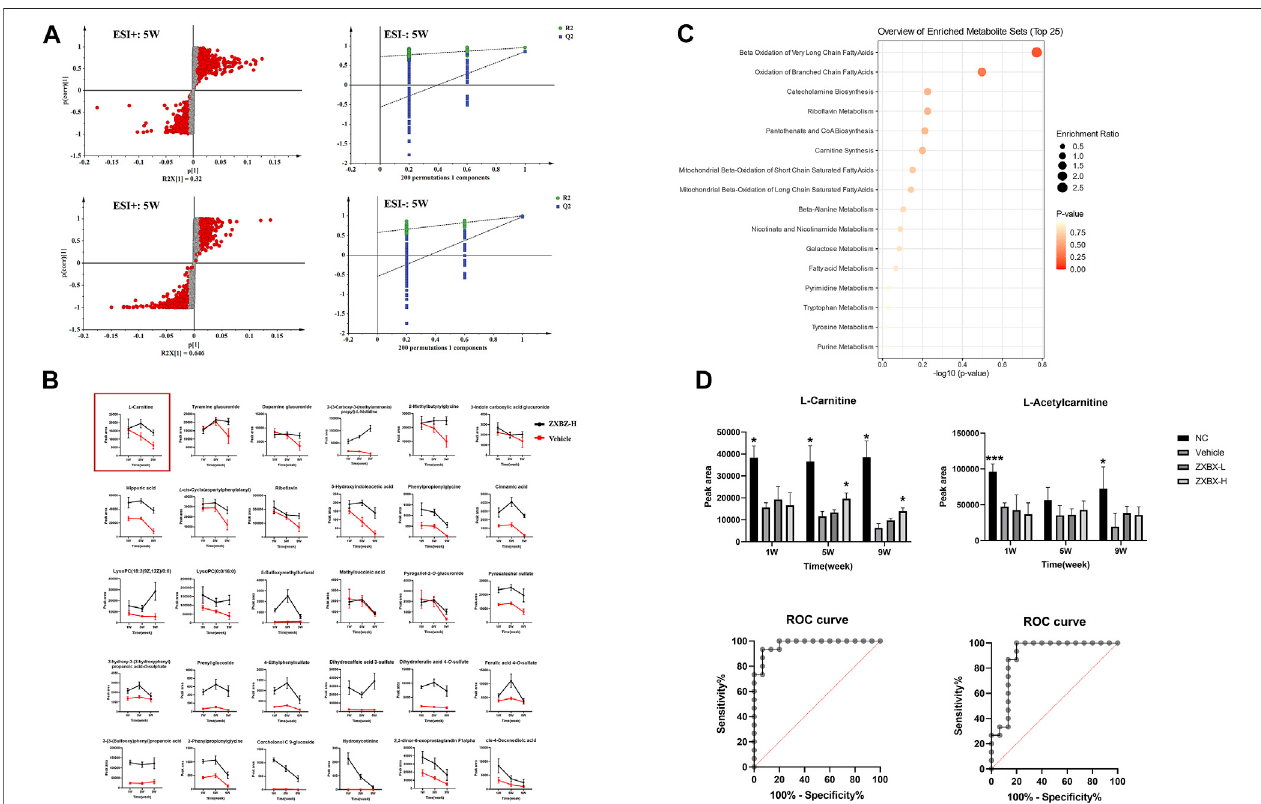
FIGURE 3 | Metabolomics revealed that ZXBZ decoction could improve the β -oxidation. (A) OPLS-DA s-plot and permutations of urine data in the positive mode andnegativemodeat fi fthweek. (B) Relativeintensitiesof30metabolitesstablypresentinthreesamples. (C) Summaryofpathwayanalysisofurinesamples. (D) Relative intensities and receiver operating characteristic (ROC) for L-carnitine and L-acetylcarnitine.